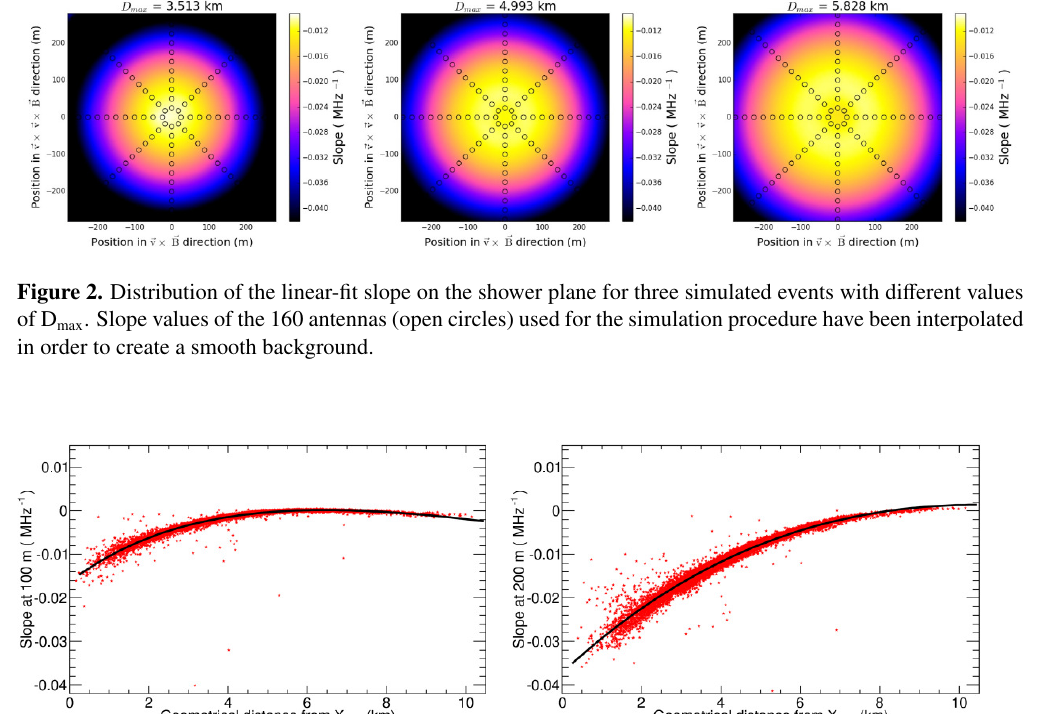
Figure 1. Left: distribution of log 10 distribution has been fitted with a linear function, taking into account 20% uncertainty on the into logarithmic values. Right: distribution of the linear-fit slope as function of distance to the shower core for one selected event (blue squares) and the corresponding simulated event (red stars). Both distributions have been fitted with a parabolic function.